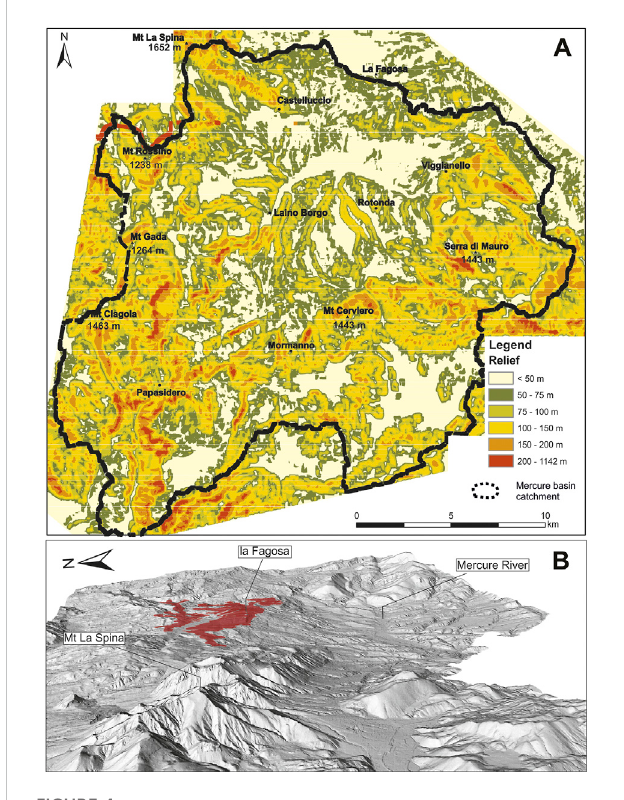
FIGURE 4 (A) Relief map of the study area (size of the moving windows: 200 m).Low-reliefsectorsathigheraltitudesalongthecarbonateridges roughly coincide with the remnants of the erosional surfaces whereas fault slopes are mainly represented by alignments of high relief areas. (B) View to the east of the low-relief palaeolandscape located along the top of the la Fagosa ridge. Note the north-eastern gentle dip toward the valley of the Sinni River of the erosional surface remnants.